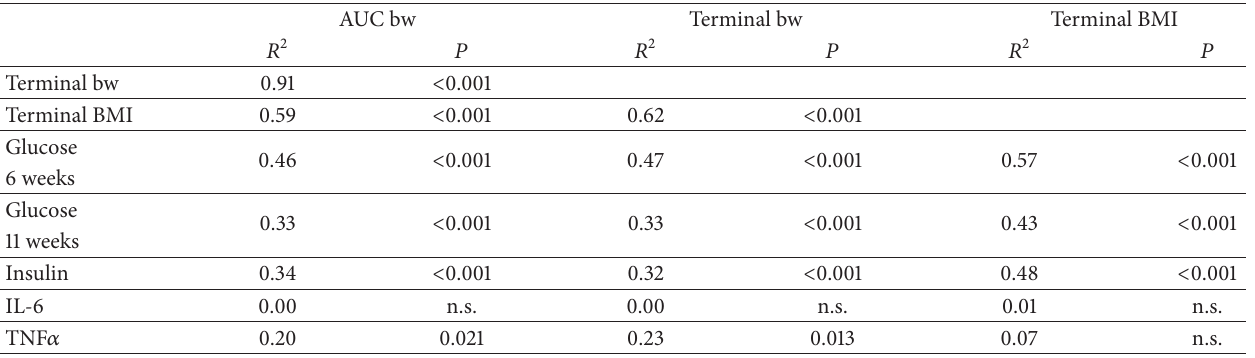
Table 2: Associations between various parameters for body weight and glucose, insulin and cytokine levels.